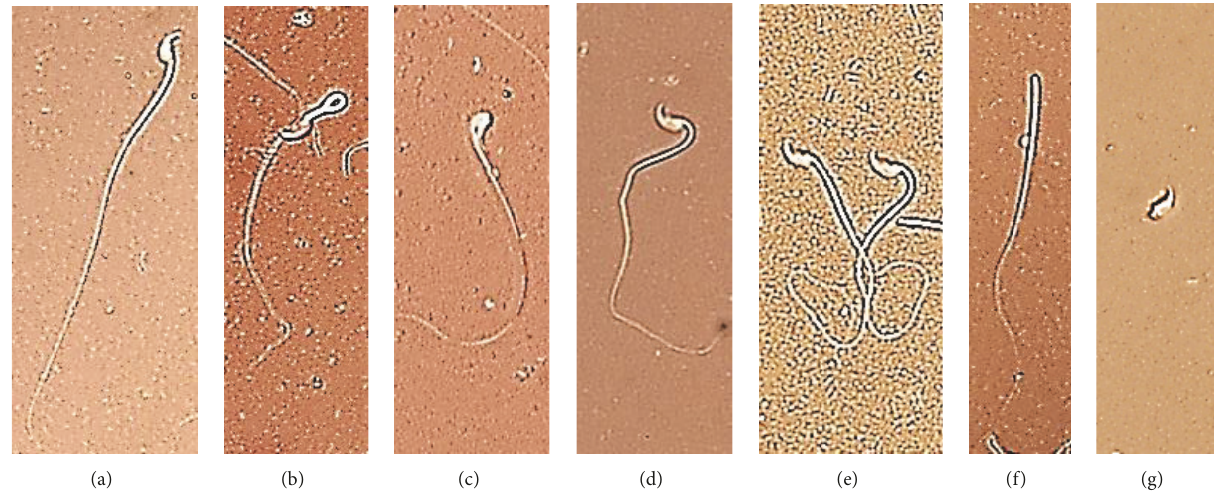
Figure 2: Normal and abnormal sperm forms: (a) normal, (b) looped midpiece, (c) pin head, (d) bend neck, (e) coiled tail, (f) headless, and (g) tailless (Eosin-Nigrosin staining, magnification: × 640 ).